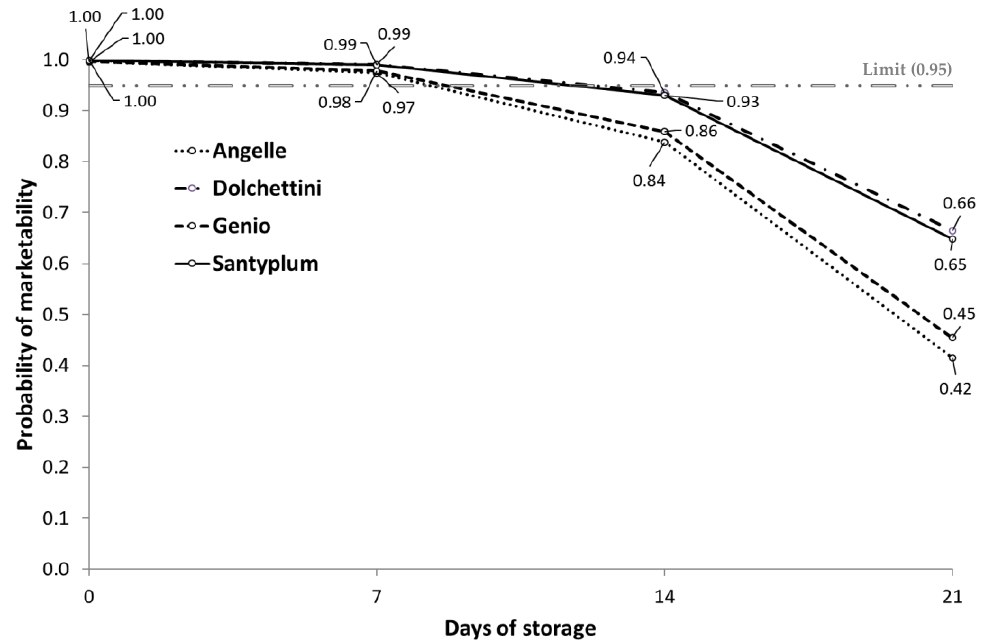
Figure 3. Temporal evolution of the marketability probability based on days of storage for the ‘Angelle’, ‘Genio’, ‘Dolchettini’, and ‘Santyplum’ cultivars.